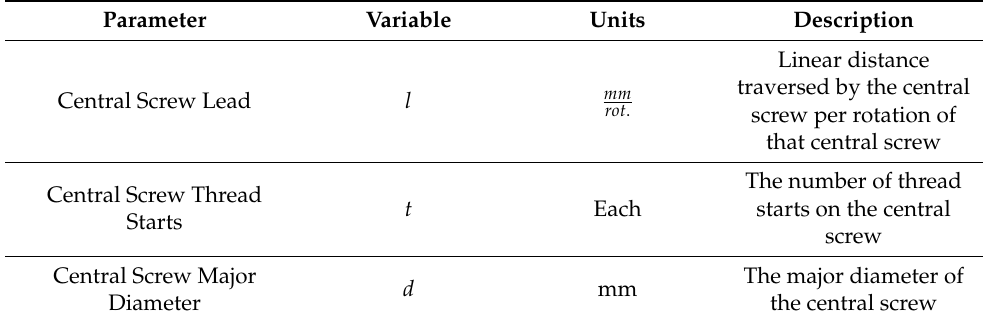
Table 1. Primary functional parameters of a planetary roller screw.